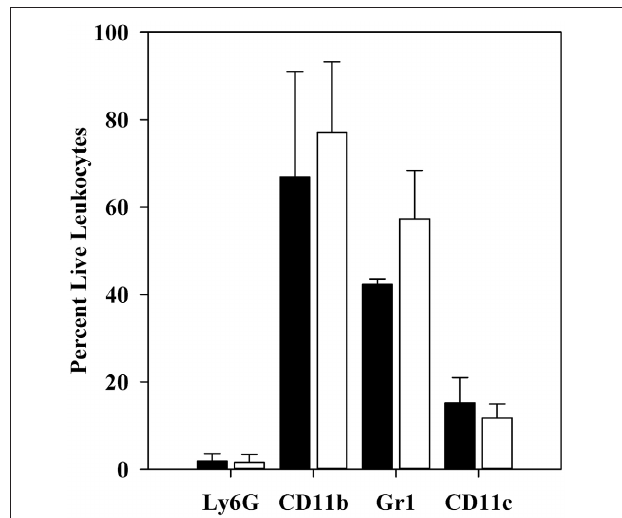
FIGURE 3 | Flow cytometric analysis of CD11b + cell populations after 1h infection. C57BL/6 mice were infected for 1h with 10 6 thermally-induced parent or (cid:2) yopM-1 Y. pestis , and CD11b + cells were obtained from spleens as described in the legend to Figure 2 . Samples were analyzed by flow cytometry for the presence of Ly6G, CD11b, Gr1, CD11c, and for staining by EMA. The bars represent the averages ± SD of the percent live leukocytes. Solid bars, mice infected with parent Y. pestis (pooled data from two experiments and 8 mice); open bars, mice infected with (cid:2) yopM-1 Y. pestis (pooled data from three experiments and 12